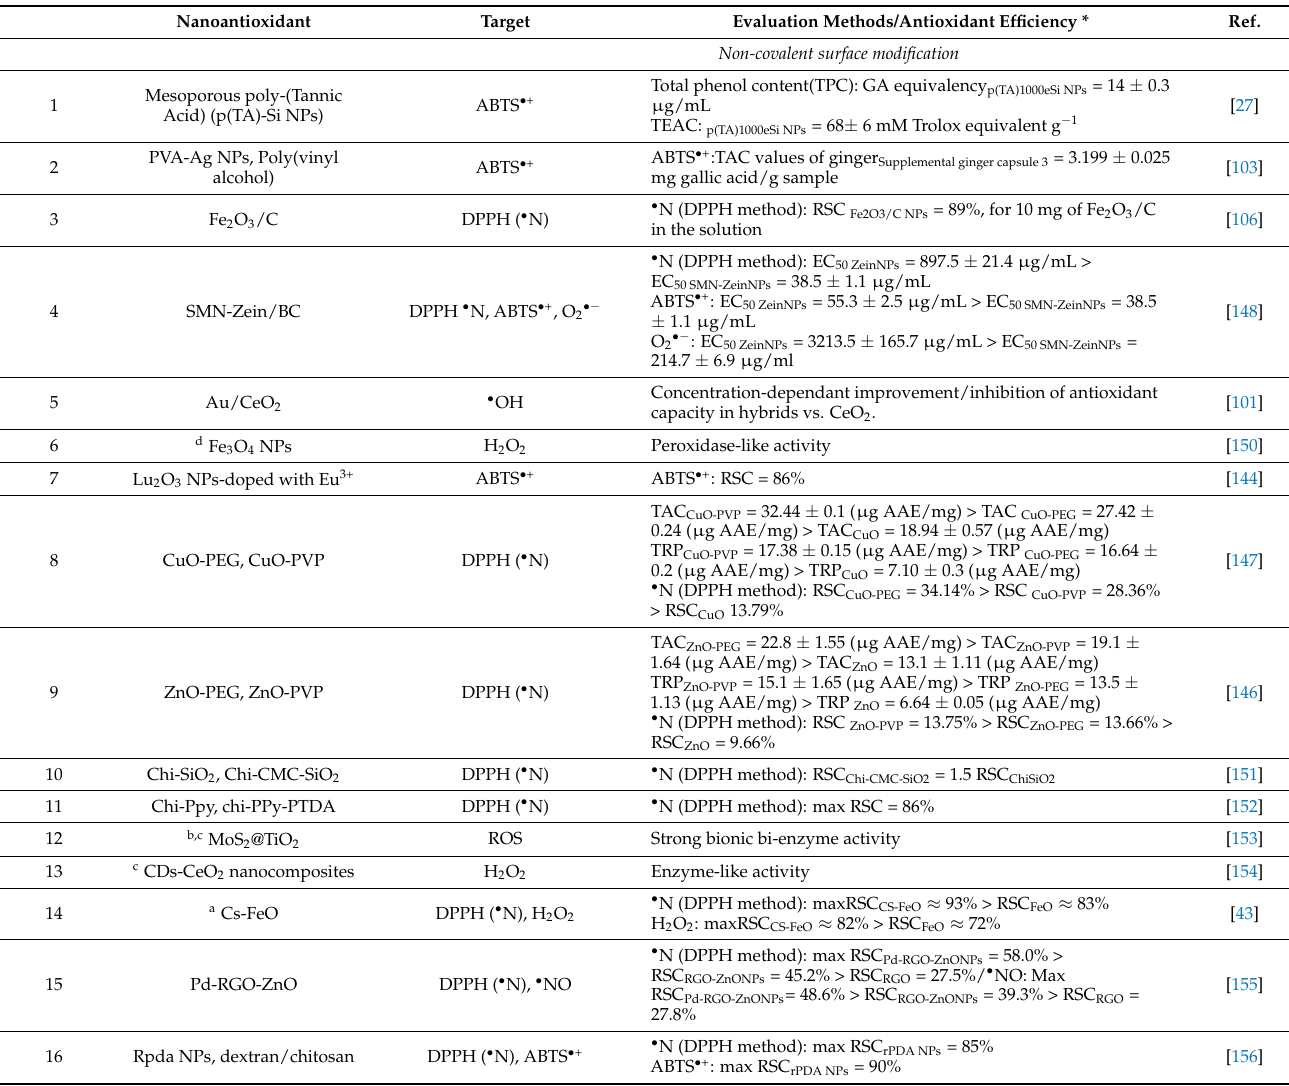
Table 3. List of (i) engineered nanoantioxidants developed through non-covalent surface modification and (ii)